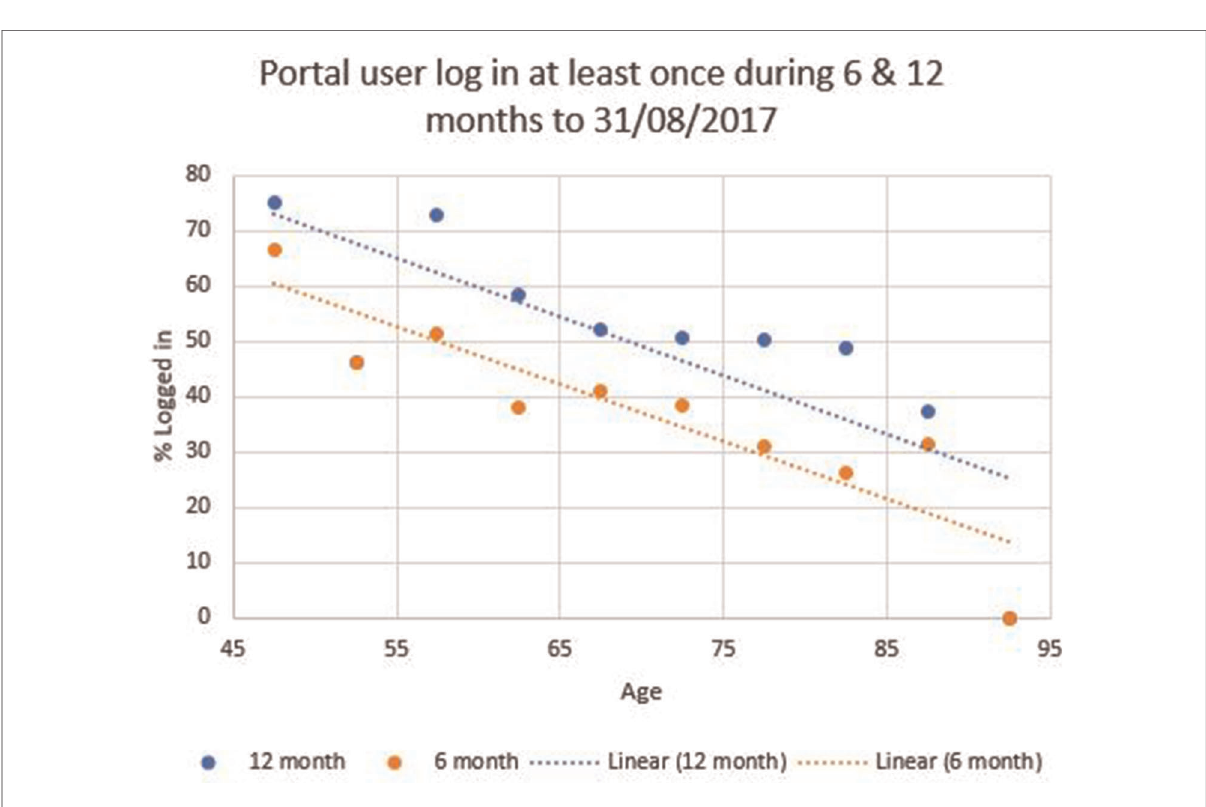
FIGURE 3 User log in over prior 6- and 12-month